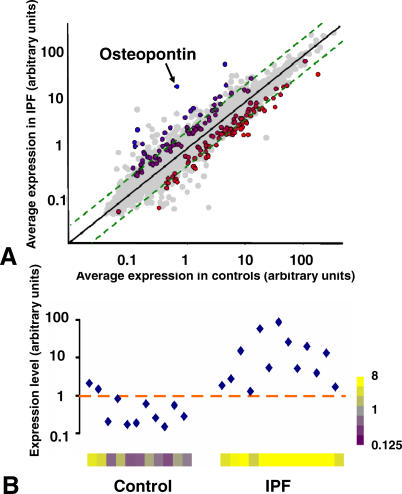
Osteopontin Expression Levels by Microarray Analysis from Controls and IPF LungsTotal RNA was used to generate double-stranded cDNA and biotin-labeled cRNA. Fragmented cRNA was hybridized to Codelink Uniset I slides and stained and scanned as described in Materials and Methods.(A) A log scale scatter plot of the average of intensity of all the genes on the arrays in controls (x-axis) and IPF (y-axis). Colored points indicate 178 genes that were significantly changed (p < 0.01 in TNoM and Student's t-test). Points are colored by their fold ratios; progressive shades of blue indicate increase, and progressive shades of red indicate decrease. Points colored in gray did not reach significance. Oblique solid line indicates the line of equality. Two green dashed lines are lines that depict 10-fold change.(B) Osteopontin levels in individual samples are shown. The y-axis is expression level in arbitrary fluorescence levels (log scale). The blue quadrangles are osteopontin levels in individual samples. Heat map shows sample osteopontin levels normalized to the geometric mean of osteopontin in controls and log base 2-transformed.